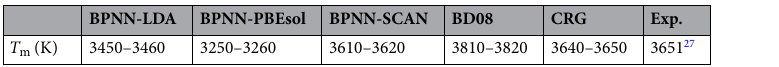
Table 5. The melting points evaluated by two phase